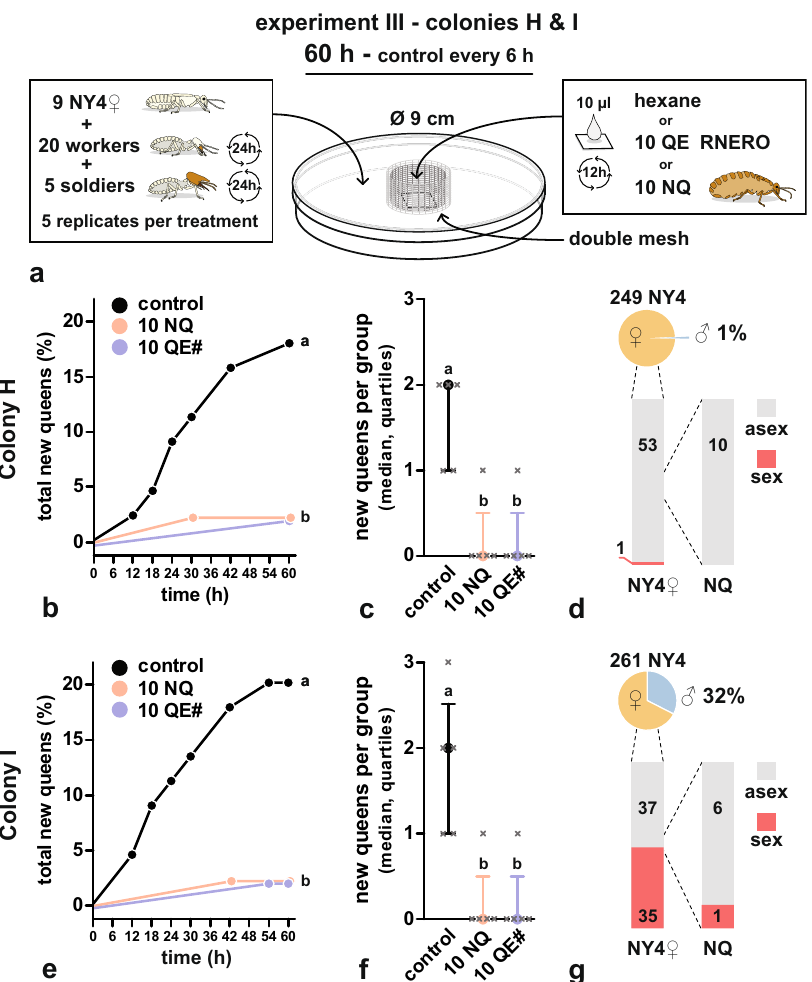
Fig. 5 RNERO acts as an airborne signal and inhibits the development of new queens from female nymphs without physical contact with its source. a Design of queen inhibition experiment with colonies H and I. b and e Cumulative numbers of new NQs in solvent control and under different treatments. Highly signi fi cant overall differences among all curves (Mantel – Cox test; colony H: χ 2 = 10.96, df = 2, p = 4.2 × 10 − 3 ; colony I: χ 2 = 13.16, df = 2, p = 1.4 × 10 − 3 ) were due to signi fi cant differences of 10NQ and 10QE# treatments from the control. Different lowercase letters indicate signi fi cant differences at α = 0.05 corrected using Sidak correction for multiple comparisons (pairwise Mantel – Cox test comparisons of all curves). c and f Median numbers (and quartiles) of new NQs per one experimental group, showing signi fi cant overall differences (KW rank-sum test; colony H: H = 9.62, groups = 3, n = 15, p = 6 × 10 − 3 ; colony I: H = 9.56, groups = 3, n = 15, p = 6 × 10 − 3 ). Different lowercase letters indicate signi fi cant pairwise differences at α = 0.05 in Dunn ’ s Multiple Comparison Test. d and g Pie charts show the numbers of NY4 found in the colonies (pie size) and the proportion of males among NY4. Left columns show proportions of sexually (sex) and parthenogenetically (asex) produced NY4 ♀ in the genotyped subset of females that entered the experiment. Right column shows the proportion of sexually and parthenogenetically produced NQs that developed in the